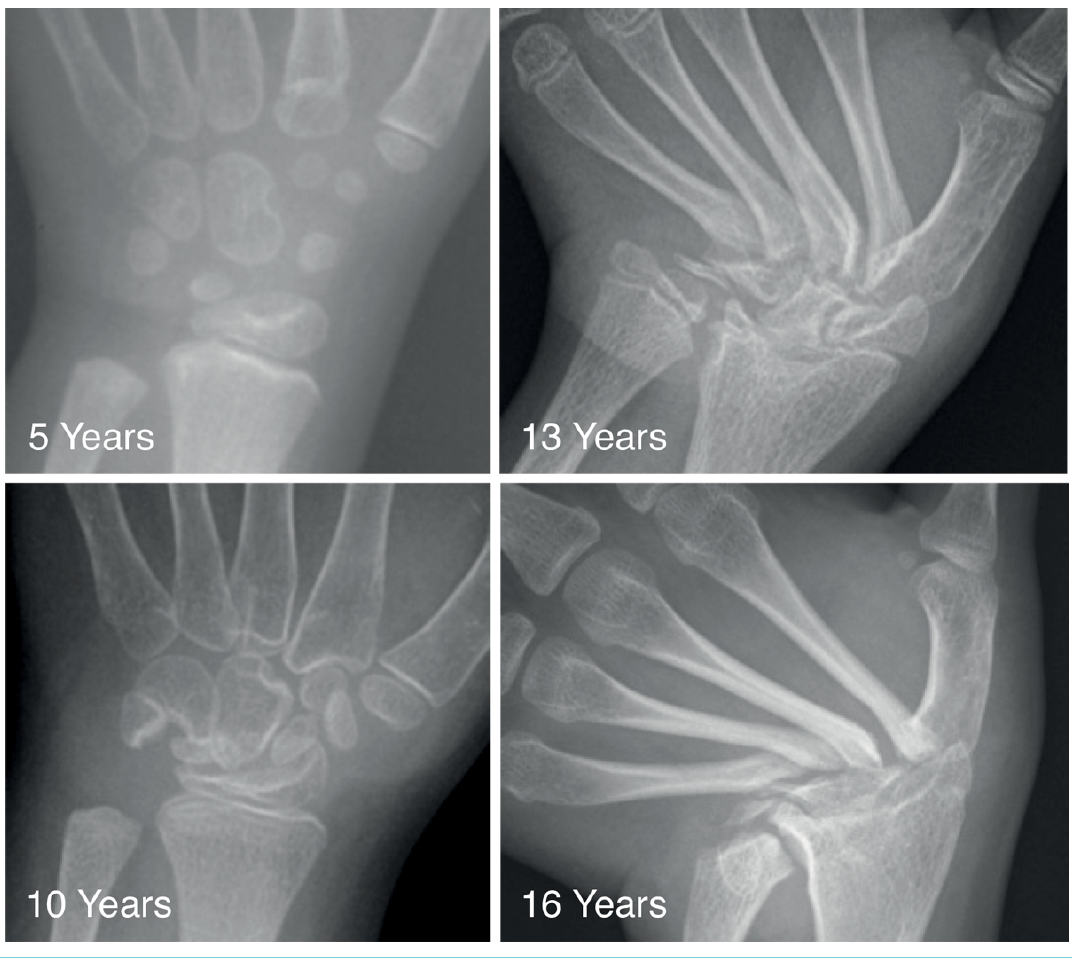
Figure 1: Phenotype of the patient. X-ray images of the hands were taken approximately every 4 years. At the age of 5 years, all carpal bones were present but thereafter, they were gradually resorbed and were completely lost at about 16 years of age. Note that most of the oth- er bones are intact. Only the metacarpal bones are affected at regions where they touch the carpal bones.